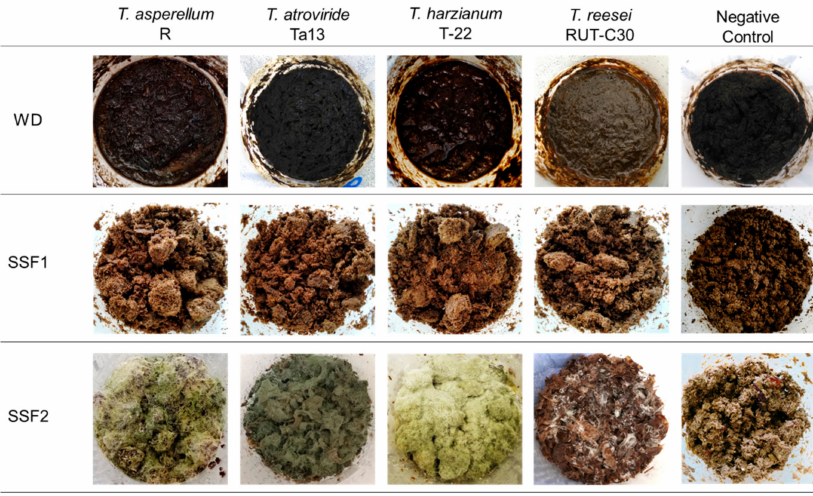
Figure 1. SSF of Trichoderma spp. after 6 days of culture on different